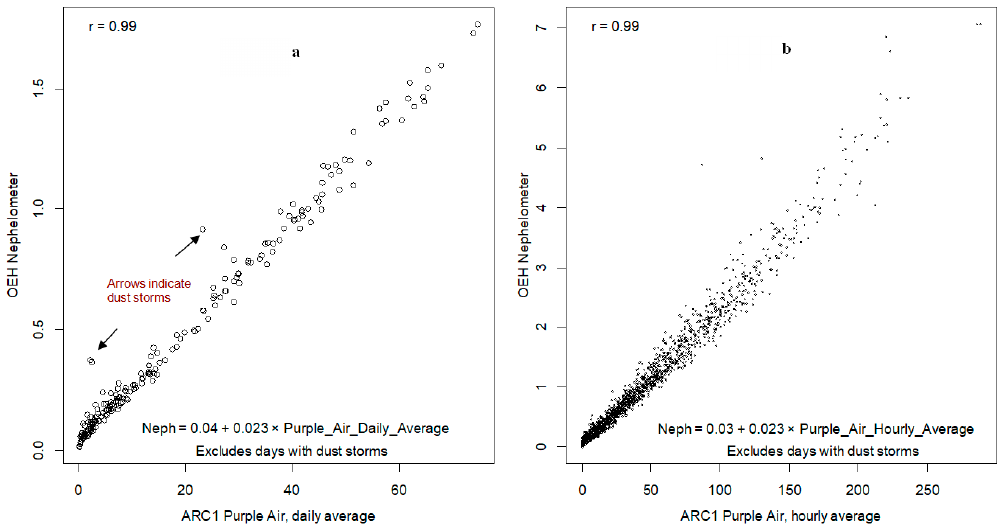
Figure 3. Comparison of daily ( a ) and hourly ( b ) nephelometer and ‘PurpleAir’ measurements (from PA ARC1, see Table 2) at the NSW government station, Armidale.